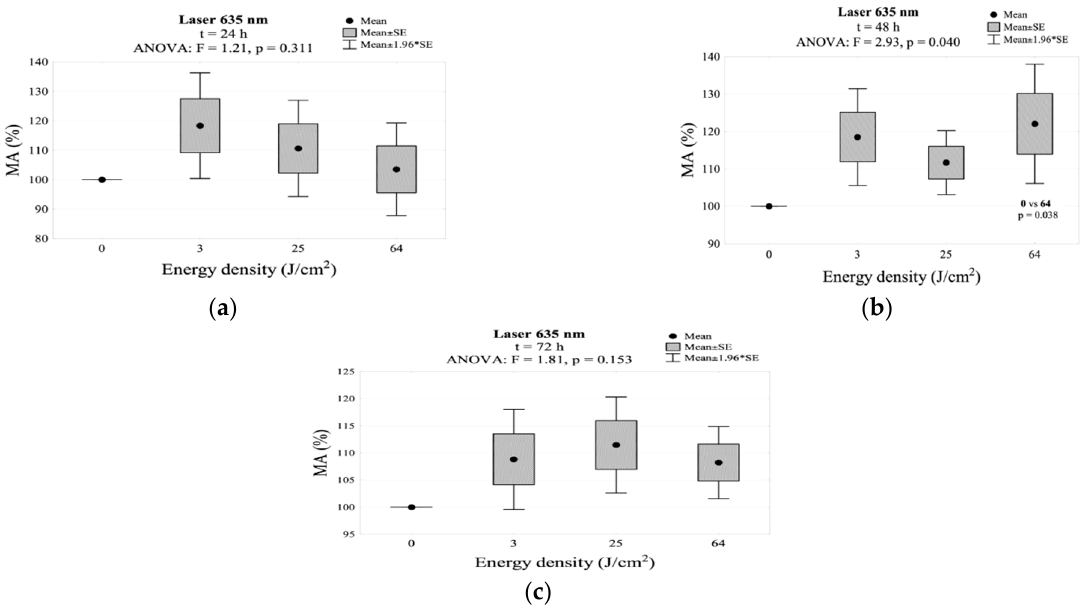
Figure 4. MA values measured ( a ) 24 h, ( b ) 48 h, and ( c ) 72 h after irradiation using the 635 nm laser. In the group simultaneously irradiated with two wavelengths (405 + 635 nm), 24 and 48 h after the exposure, the MA dropped below 100% without statistical differences com- pared to the control group. A slight increase in the mitochondrial activity was observed 72 h after the exposure without statistically significant differences in comparison to the control group. After this period, the highest MA value (102.5%) was also observed in the irradiated group with an energy density of 64 J/cm 2 . The results showing MA values with simultaneous irradiation with two wavelengths (405 + 635 nm) are presented in Table 2 and Figure 5. The interaction between energy density and incubation time after irradiation for mitochondrial activity is shown in Figure 2d. ( a )